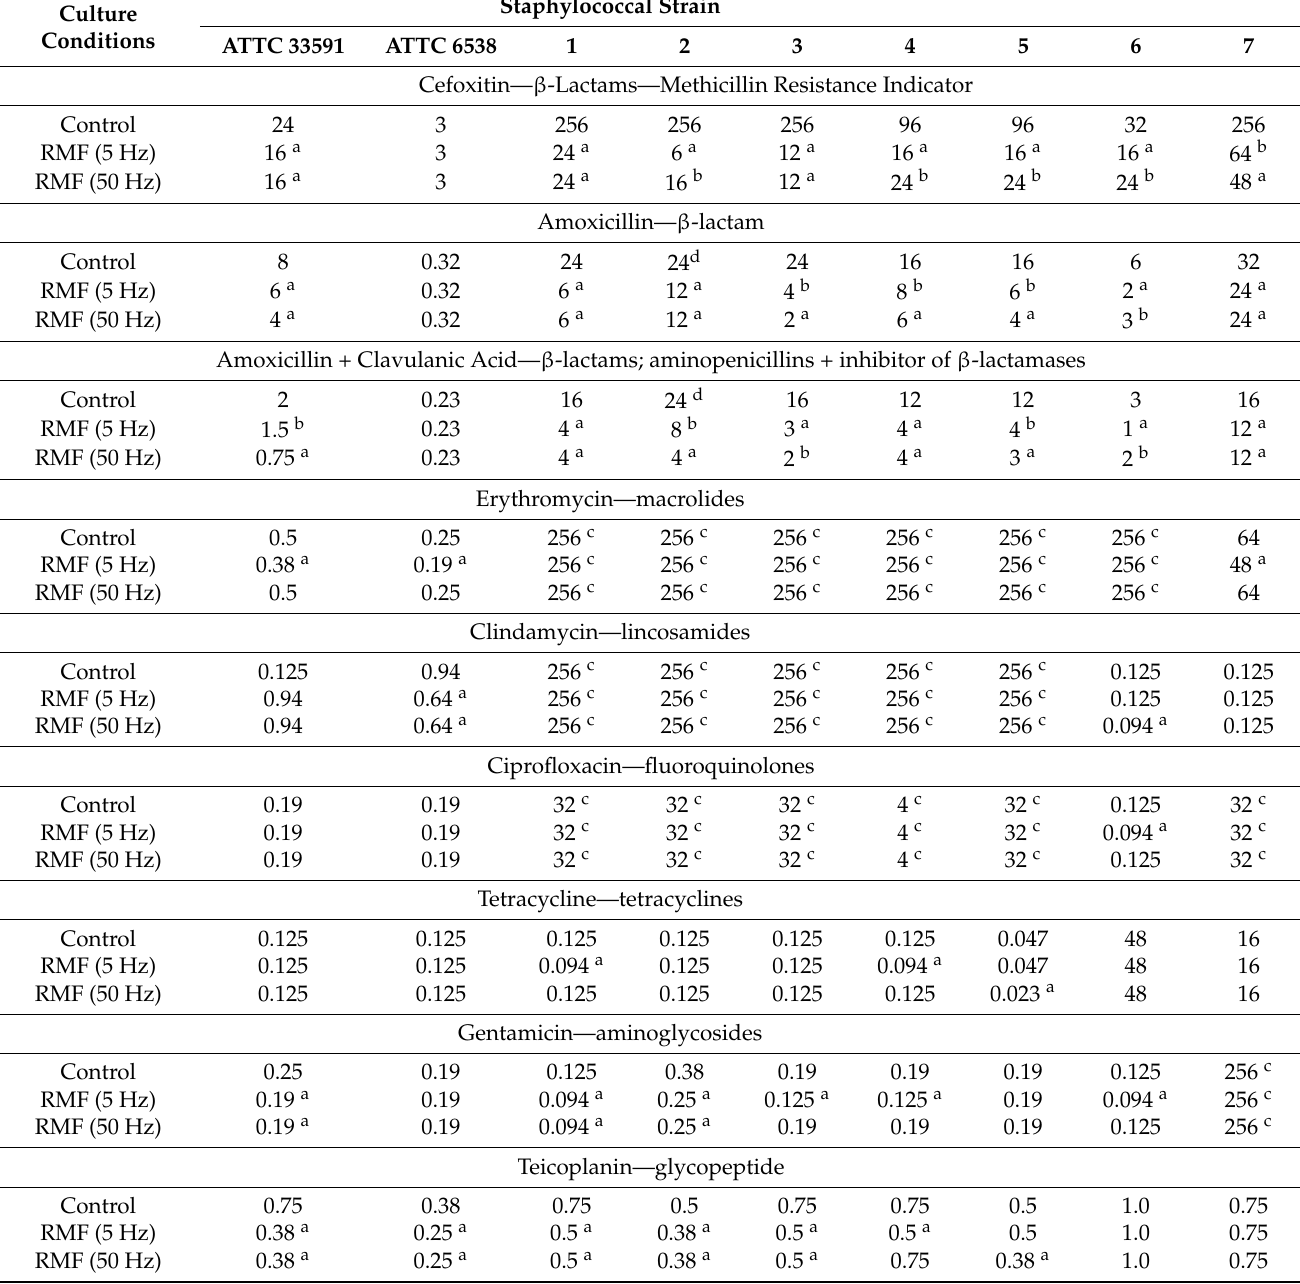
Table 2. MIC values ( µ g/mL) of β -lactam antibiotics for MRSA strains in control and RMF-exposed cultures.